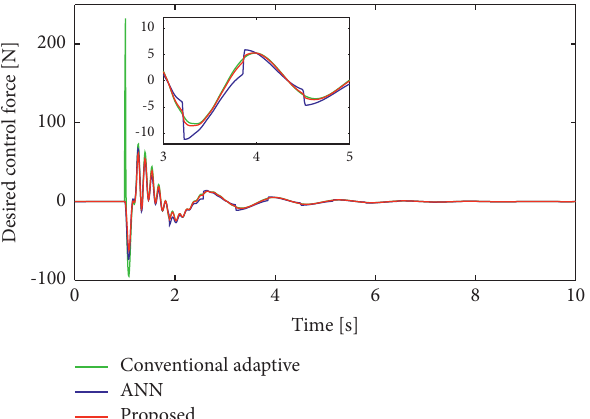
Figure 11: The comparison of control force for the system with the proposed algorithm.